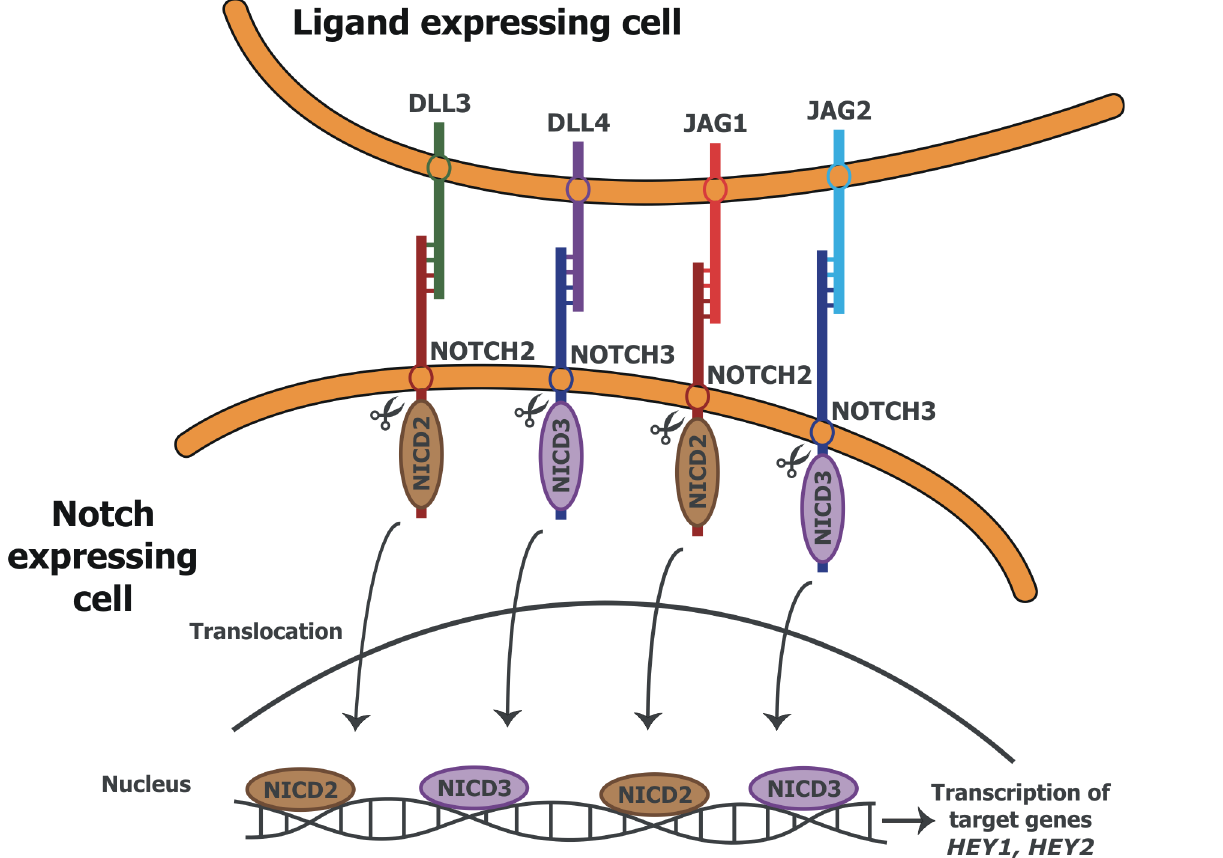
Fig 4. Schematic depiction of the studied Notch signaling pathway molecules in late preterm and term placentas.